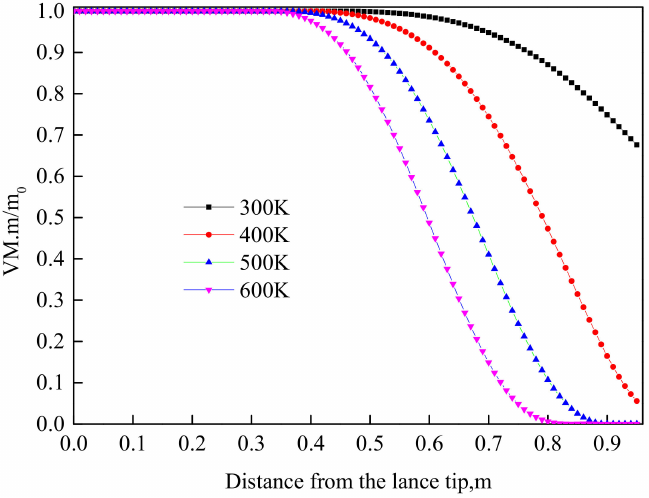
Figure 5. E ff ect of oxygen temperature on mass ratio (m / m 0 ) of volatile matter.